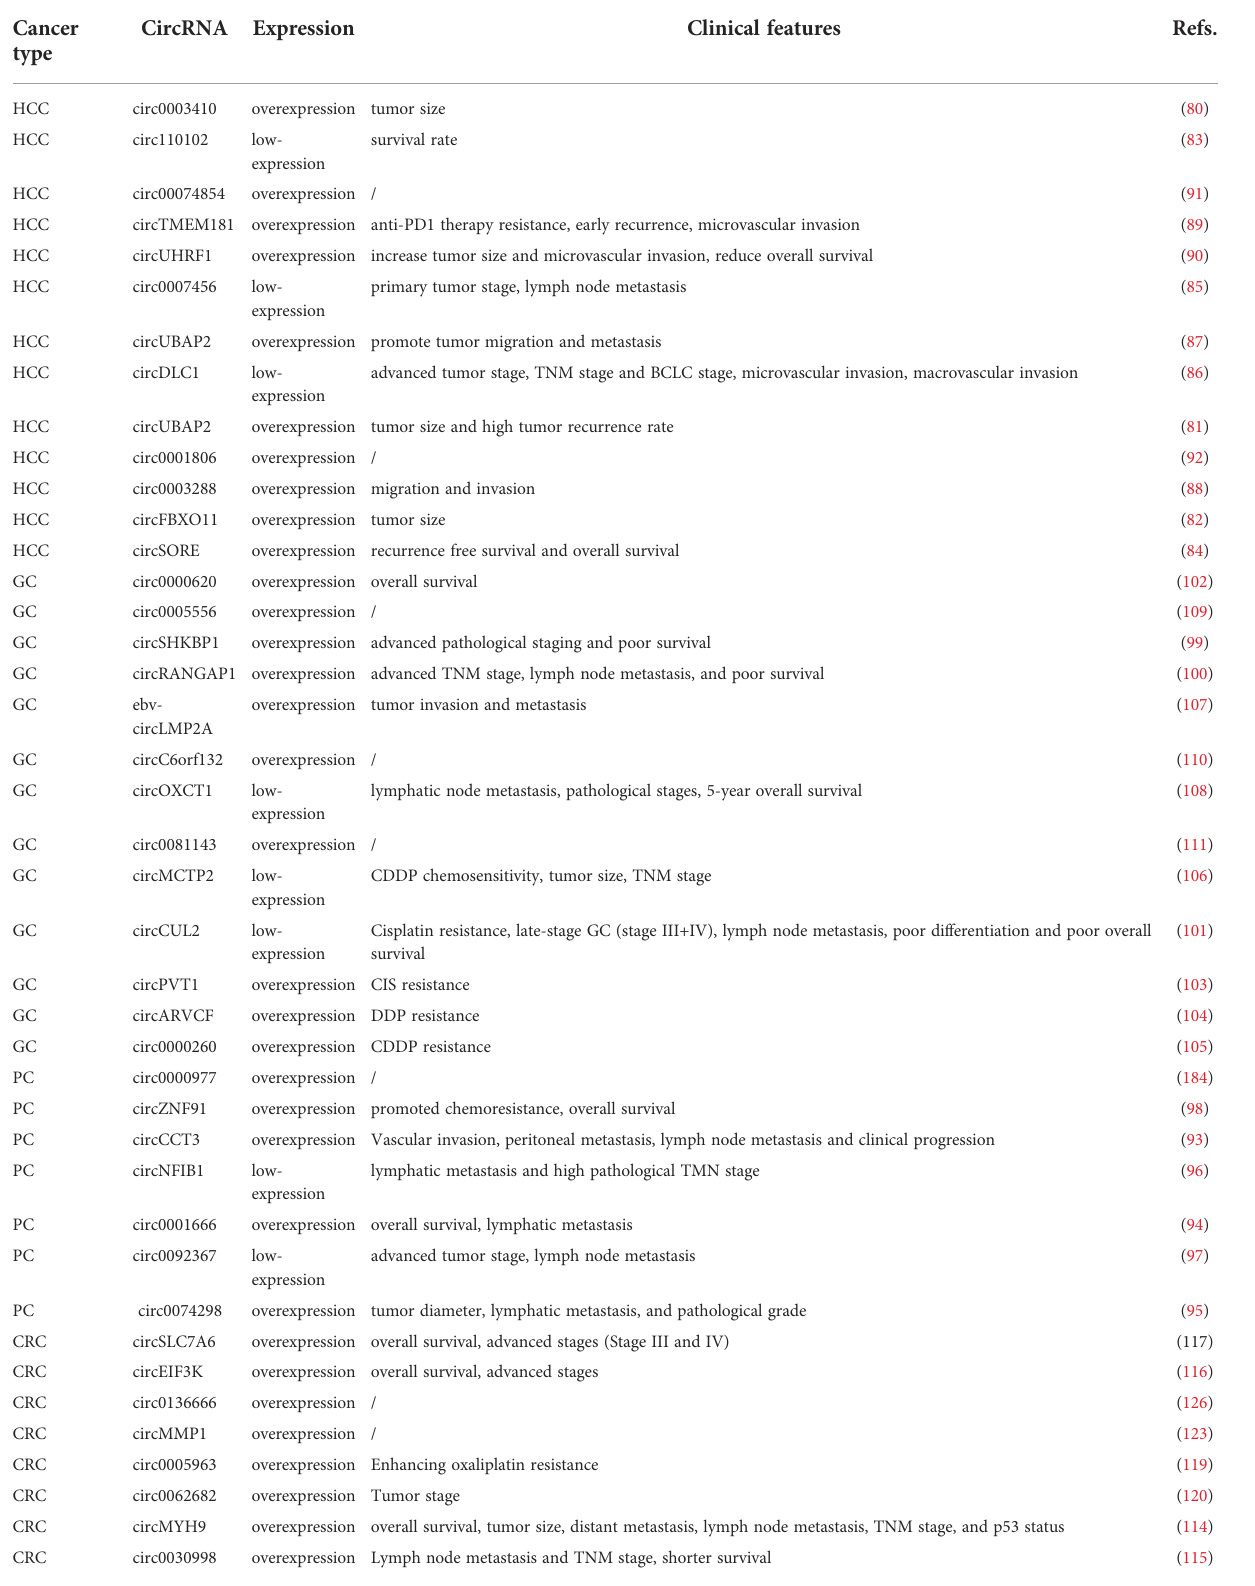
TABLE 2 Correlation of circRNAs with clinical features in digestive system tumors. Cancer